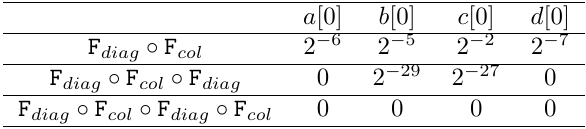
Table 2: Biases of the linear characteristics with 1 active bit in the input.